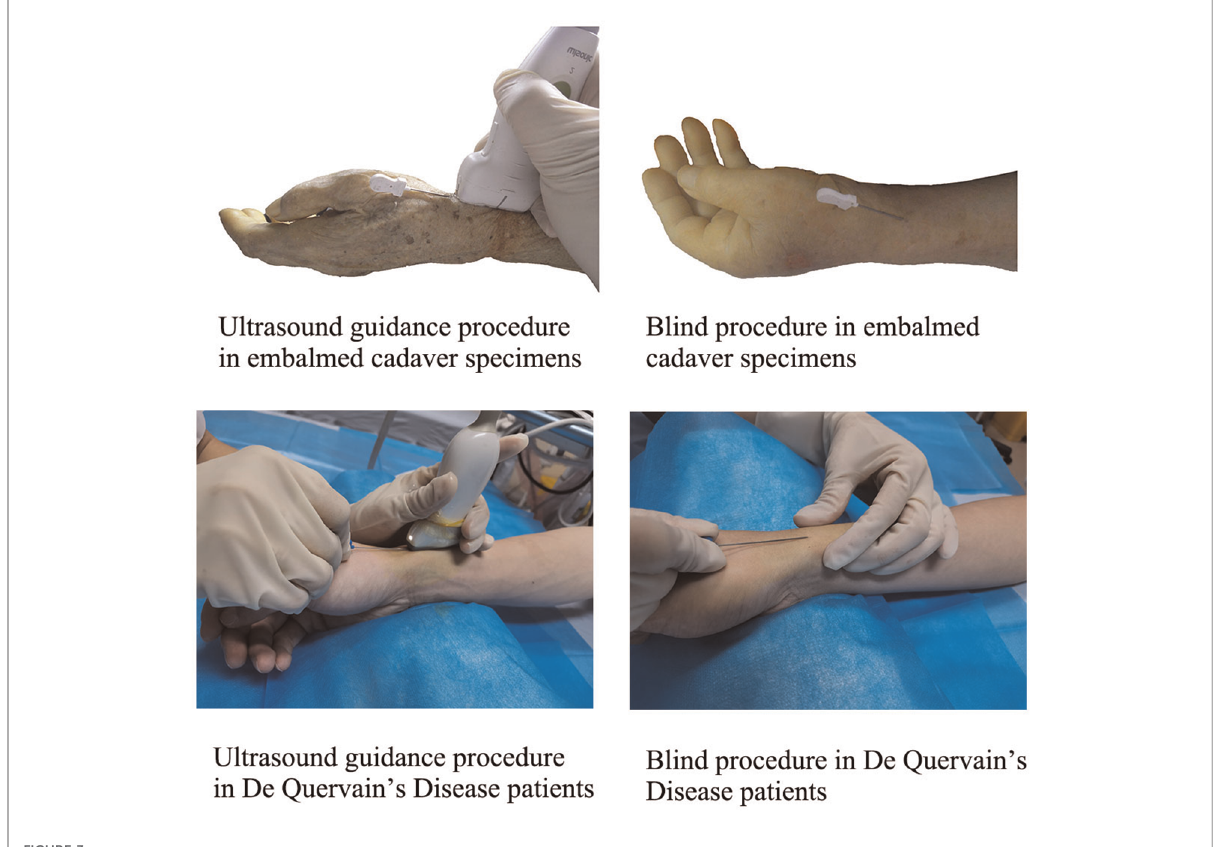
FIGURE 3 Ultrasound-guided acupotomy procedure and blind acupotomy procedure.